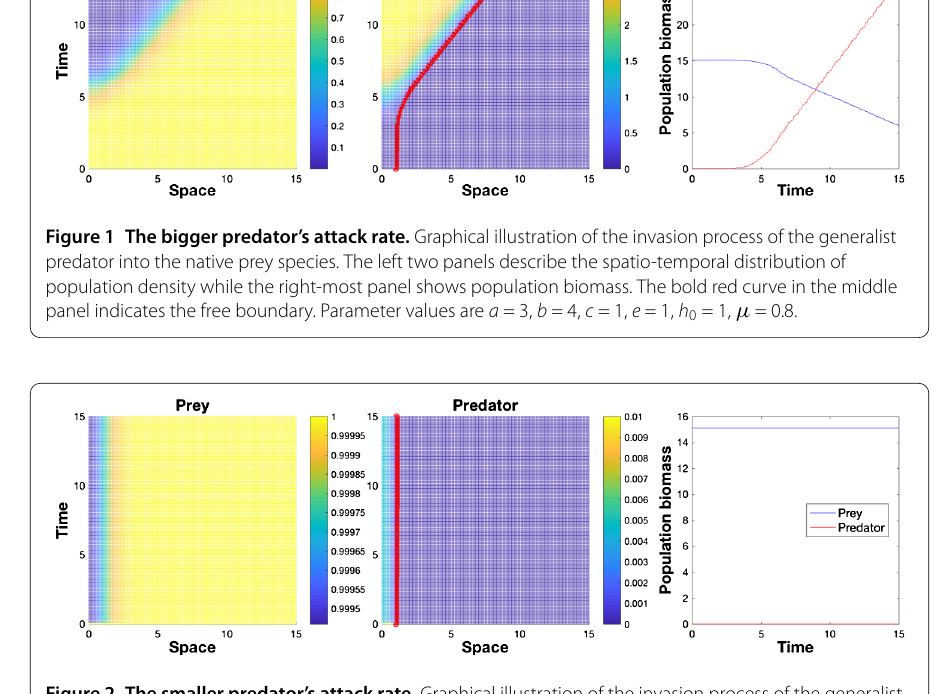
Figure 2 The smaller predator’s attack rate. Graphical illustration of the invasion process of the generalist predator into the native prey species. The left two panels describe the spatio-temporal distribution of population density while the right-most panel shows population biomass. The bold red curve in the middle panel indicates the free boundary. Parameter values are a = 3, b = 3, c = 1, e = 1, h 0 = 1, μ =